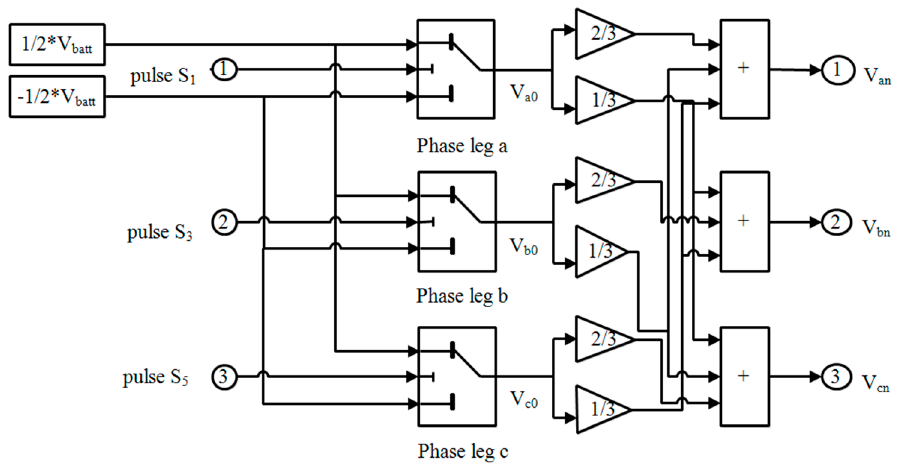
Figure 6. Three phase voltage source inverter. The combination of three switching states gives out eight possible voltage vectors. At any interval, the inverter has to operate one of these voltage vectors. Among the eight voltage vectors, two are zero voltage vectors (V0 and V7) and the remaining six (V1 to V6) are active voltage vectors. In the space vector plane, all of the voltage vectors can be represented as shown in Figure 7. In the SVPWM algorithm, the boundary for the modulation index is 0.866. In this strategy, the total time interval of the zero voltage vector is equally distributed between V0 and V7. In addition, the zero voltage vector time is distributed symmetrically at the start and end of the sub cycle in a symmetrical manner. Furthermore, to lessen the switching actions of the VSI, it is required that switching should take place in one phase in one transition from one state to another. Consequently, the SVPWM uses 0127–7210 in first sector, 0327–7230 in the second sector and so on [13]. The block diagram of the proposed intelligent adaptive neural network based DTC scheme for an eCAR propulsion system is shown in Figure